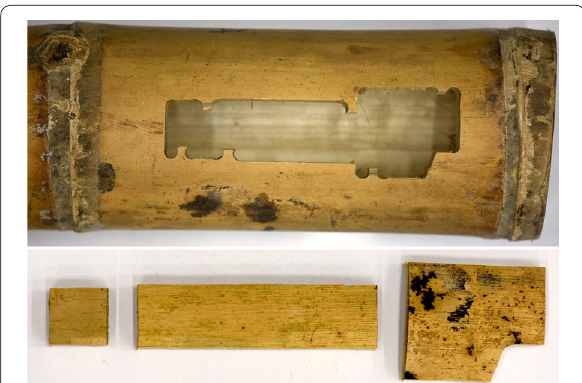
Fig. 4 Robotically fabricated small clear